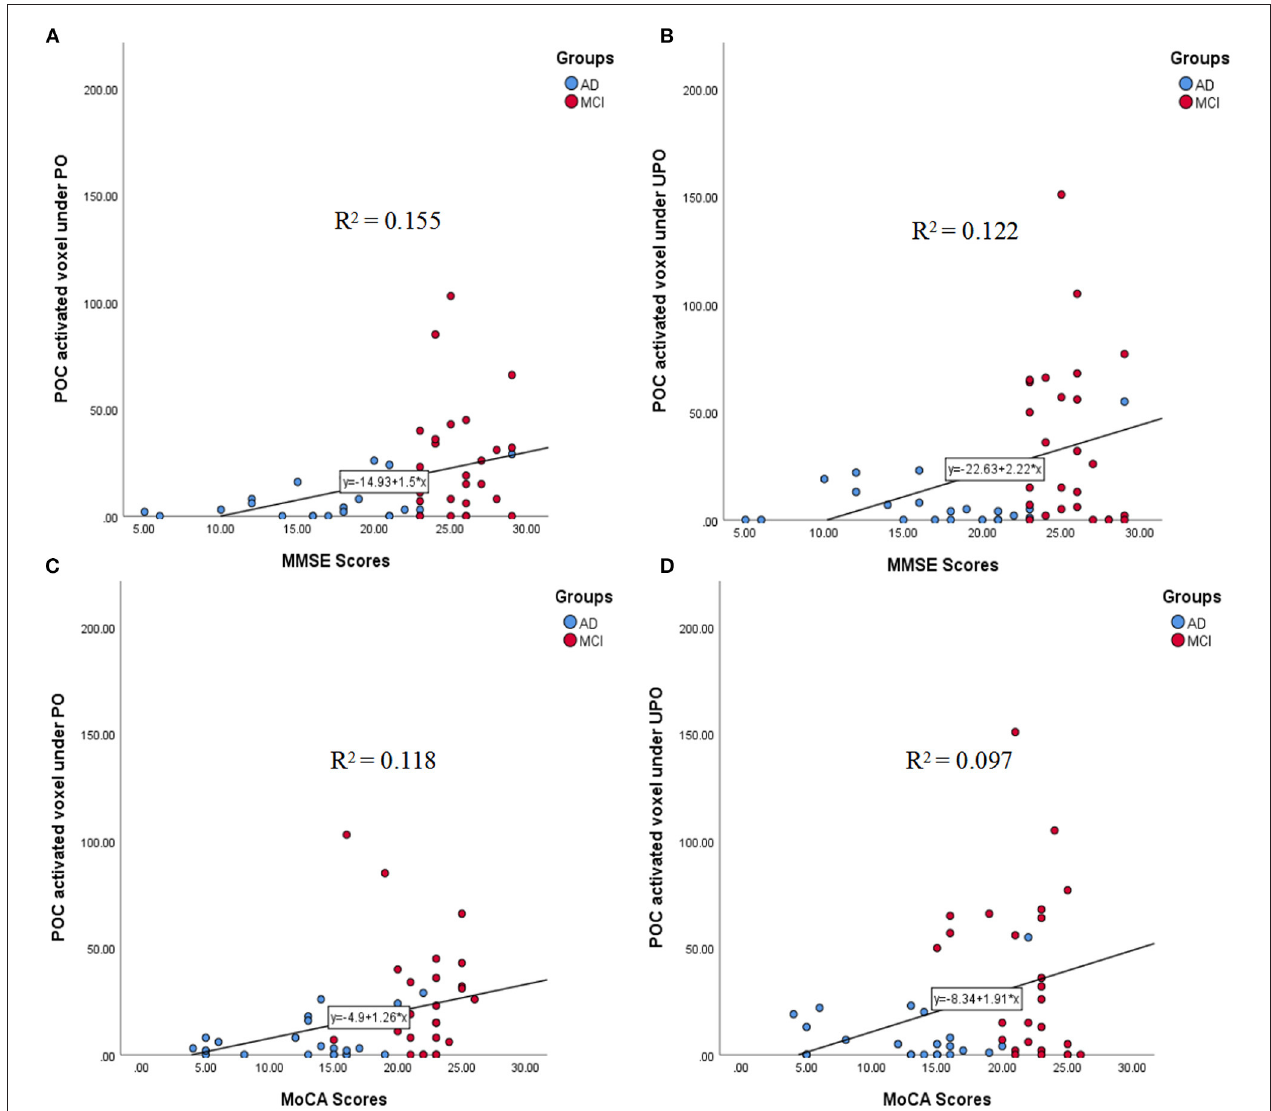
FIGURE 6 | (A–D) The correlations between the number of activated voxels in the POC and the MMSE and MoCA scores in the PO and UPO conditions. (A) There was a significant correlation between the number of POC activated voxels and the MMSE scores under PO ( r = 0.394, p = 0.005). (B) There was a significant correlation between the number of POC activated voxels and the MMSE scores under UPO ( r = 0.350, p = 0.014). (C) There was a significant correlation between the number of POC activated voxel and the MoCA scores under PO ( r = 0.344, p = 0.015). (D) There was a significant correlation between the number of POC activated voxel and the MoCA scores under UPO ( r = 0.311, p =